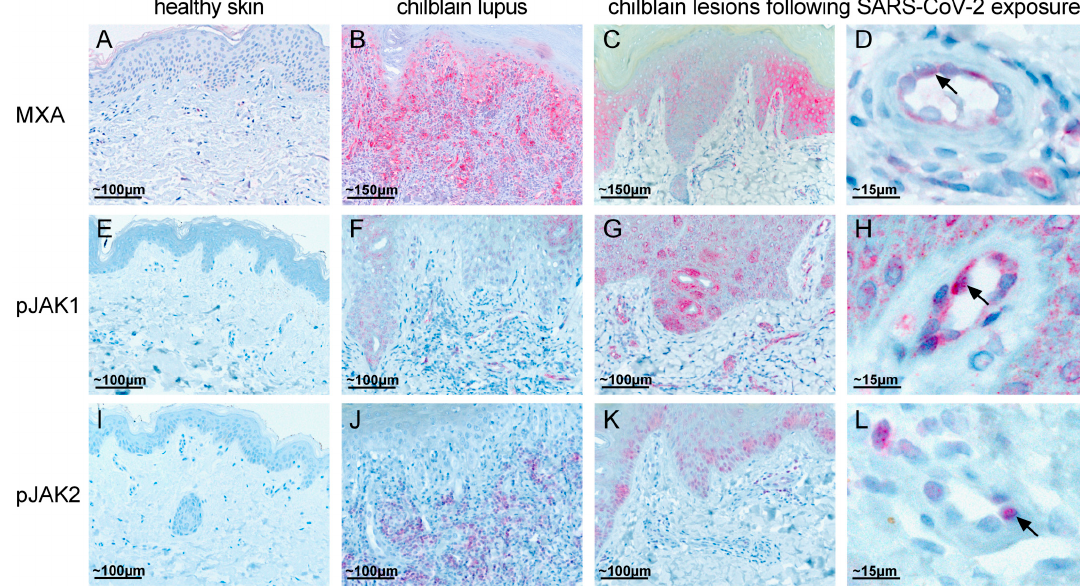
Figure 3. Immunohistochemistry demonstrating type I IFN activation. ( A – D ): Staining for MxA in red is negative in healthy skin ( A ), shows strong staining in conventional chilblain lupus ( B ), and protein induction in epidermis, dermis and endothelial cells (arrow) in lesional skin of chilblain-like lesions after exposure to SARS-CoV-2 ( C , D arrow). ( E – H ): Staining for pJAK1 in red is negative in healthy skin ( E ), shows faint staining in conventional chilblain lupus ( F ), and staining in the epidermis, dermis and endothelial cells (arrow) in lesional skin of chilblain-like lesions after exposure to SARS-CoV-2 ( G , H ). ( I – L ): Staining for pJAK2 in red is negative in healthy skin ( I ), shows staining in chilblain lupus ( J ), and faint staining in the epidermis, dermis and endothelial cells (arrow) in lesional skin of chilblain-like lesions after exposure to SARS-CoV-2 ( K , L ). ( C , D , G , H , K , L ) show representative images of stainings performed in all 3 patients. D, H, L show magnifications of the respective staining in ( C , G , K ).